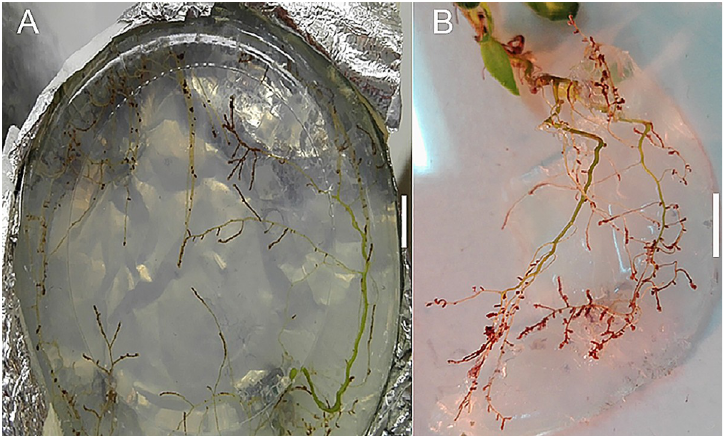
Fig 1. Example of ectomycorrhizal colonization ( C . psilosepalus + L . deliciosus ) of the root system after ( A ) two months (observed through the agar); and ( B ) 5–6 months (after removal from the agar medium) (Bar = 1cm).